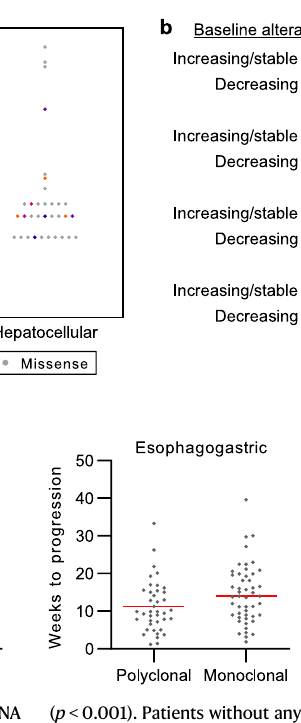
( p <0.001). Patients without any detectable baseline alterations were excluded. c Time to progression was shorter among cancers with multiple emergent altera- tions (polyclonal) versus single emergent alterations (monoclonal) in CCA ( P =0.002), EGC ( P =0.03), and HCC ( P =0.08) but not PDAC ( P